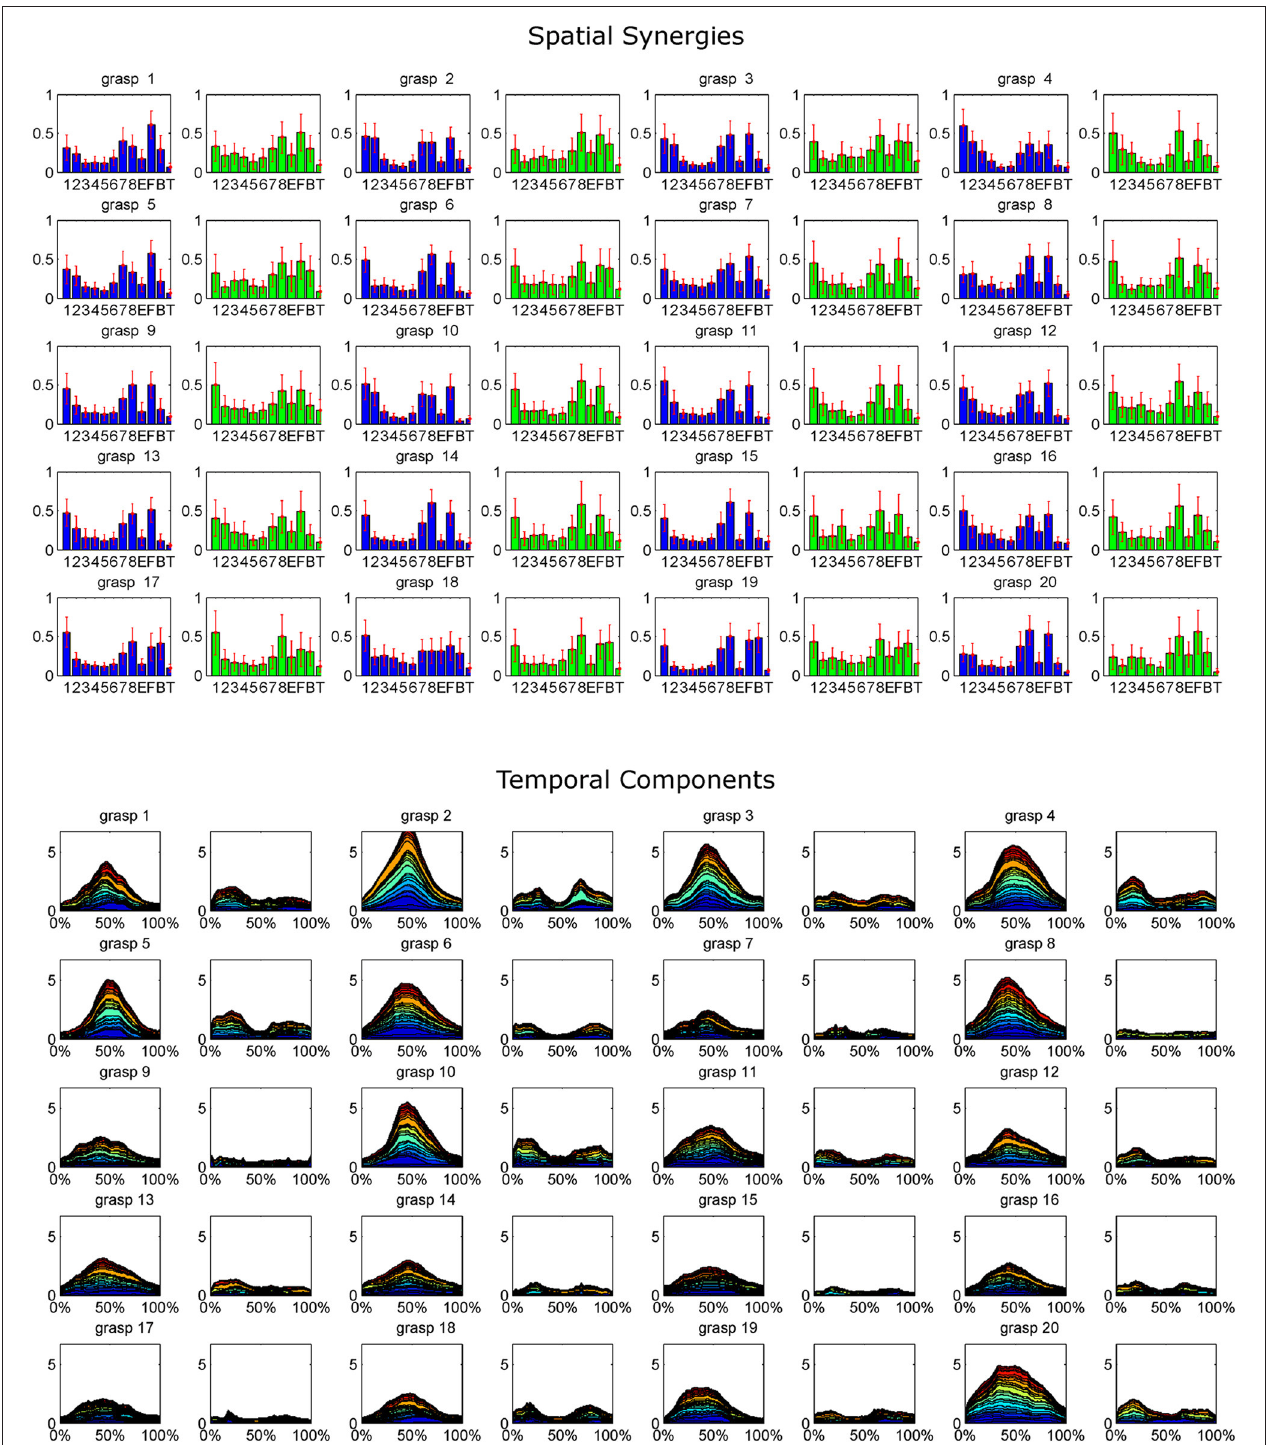
FIGURE 4 | The whole dataset of synergies extracted for each grasp is synthetically reported, coupled with the corresponding cumulated temporal components. For each grasp (numbered 1–20 as in the order shown in Figure 2 ), the mean spatial synergies are reported. The mean spatial synergies are computed by averaging the spatial synergies grouped by matching each subject’s spatial synergies according to the Pearson’s Correlation coefficient computed on the temporal components. Only the first two modules are reported for each grasp (module 1, reported in blue, exploited during the grasp phase, and module 2, depicted in green, used mainly in the pre-shaping and release phases). Mean spatial synergies are also coupled with the cumulated mean temporal components that modulate in time the mean spatial synergies, plotted as percentage of the normalized duration of each movement.